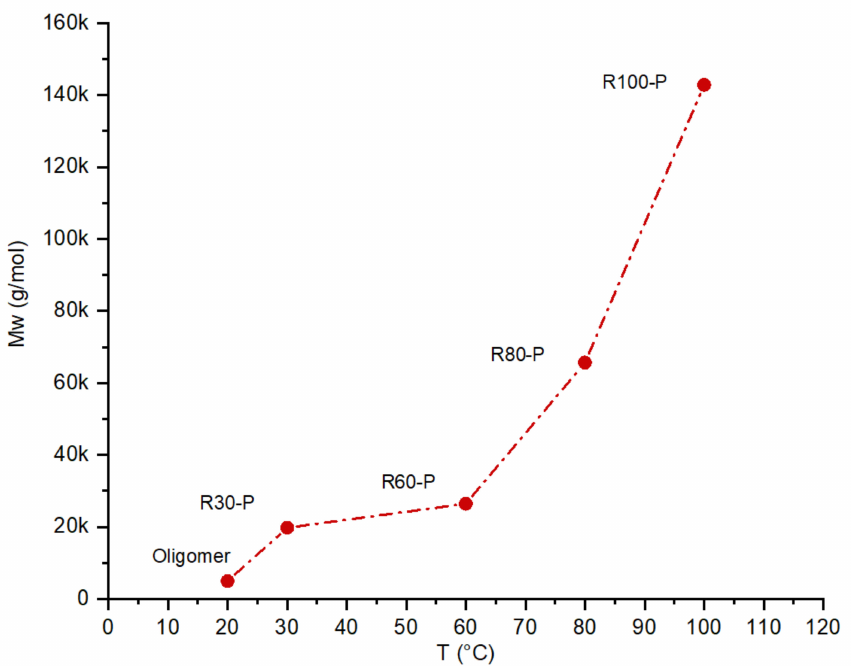
Figure 4. The effect of temperature of polymerization on the Mw (Molecular weight) of the resorcinol- formaldehyde polymer (time of polymerization, 24